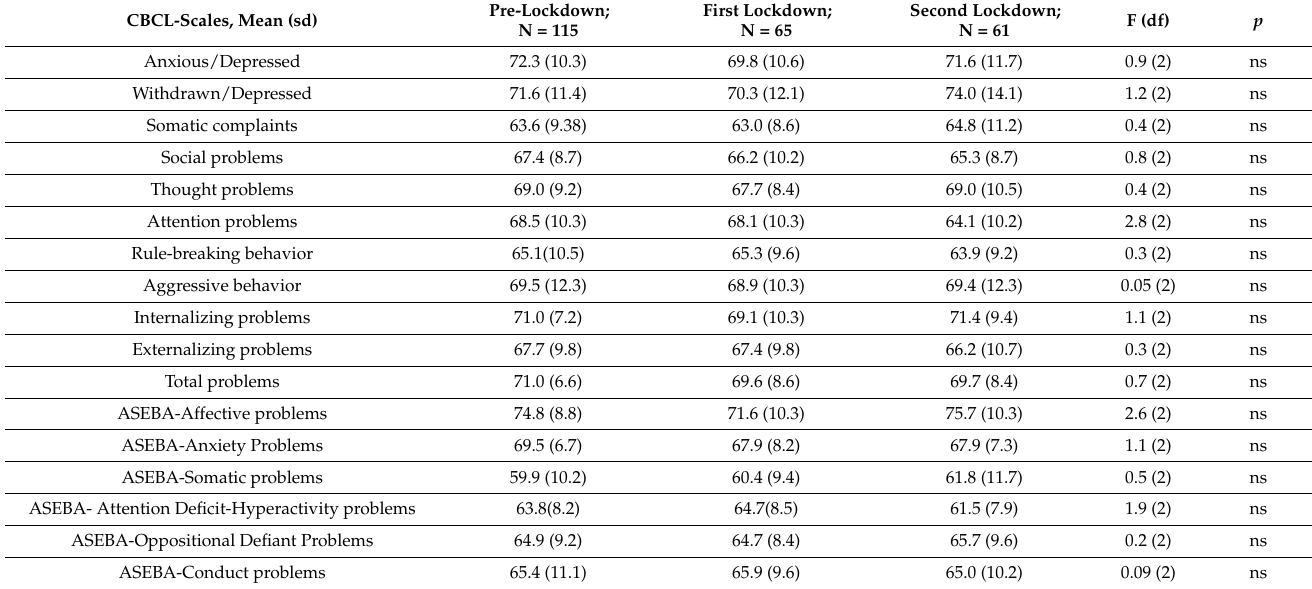
Table 2. Comparison between Pre-Lockdown (n = 115), First Lockdown (n = 65), and Second Lockdown (n = 61) groups, according to the Child Behavior Checklist (CBCL) scores.